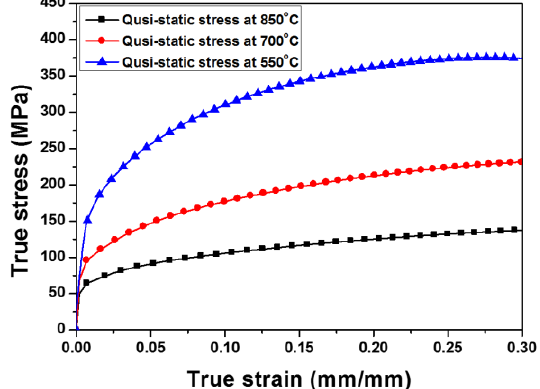
Figure 7. Strain – stress curves at the quasi-static state for boron steel. Table 4. Material constants of boron steel in the Cowper – Symonds model.